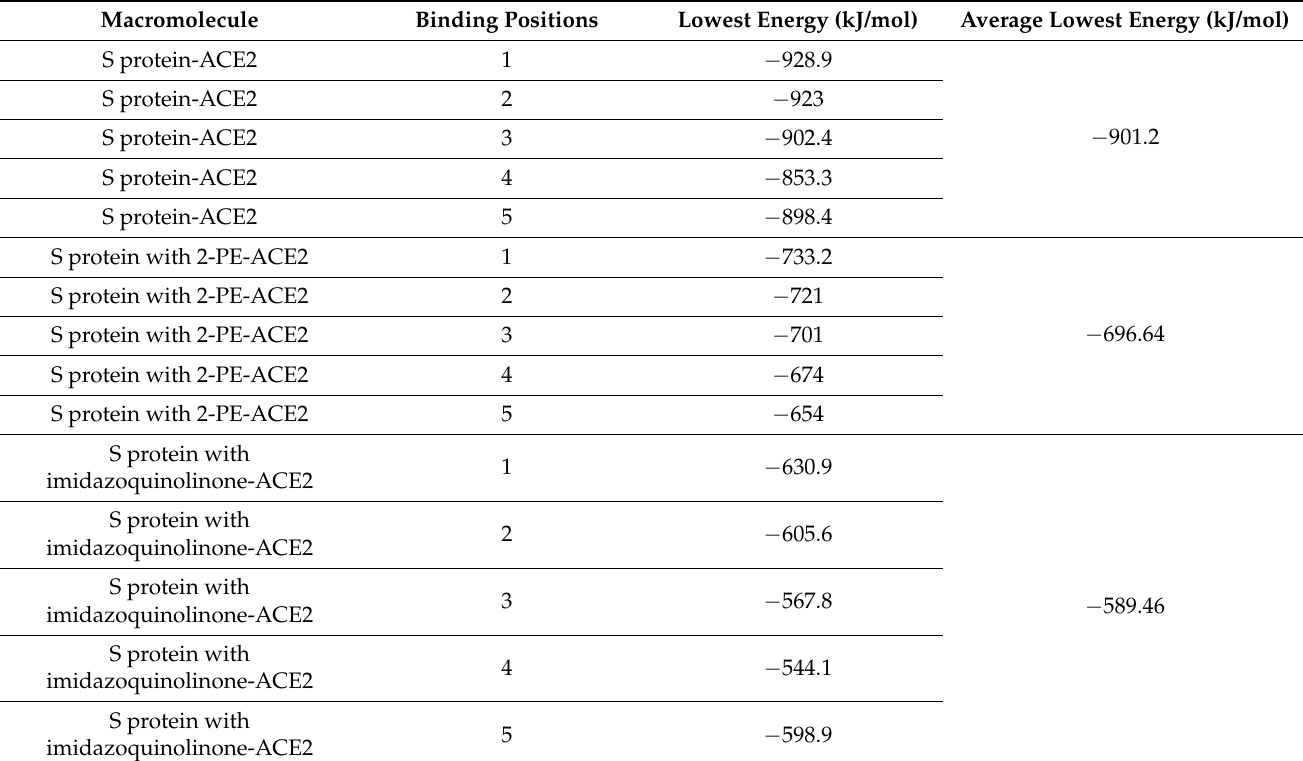
Table 2. Protein–protein interaction depicting five lowest binding energies for S protein-ACE2 com- plex in the presence or absence of Covaxin adjuvant.